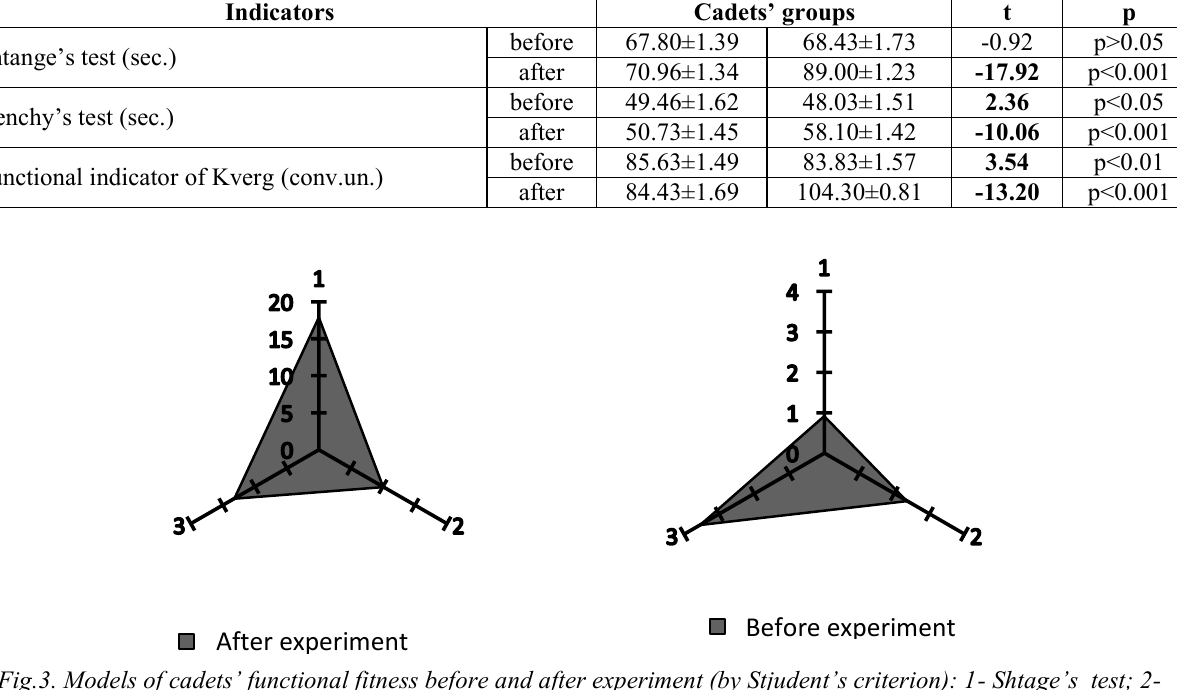
Fig.3. Models of cadets’ functional fitness before and after experiment (by Stjudent’s criterion): 1- Shtage’s test; 2- Genchy’s test; 3- functional indicators of